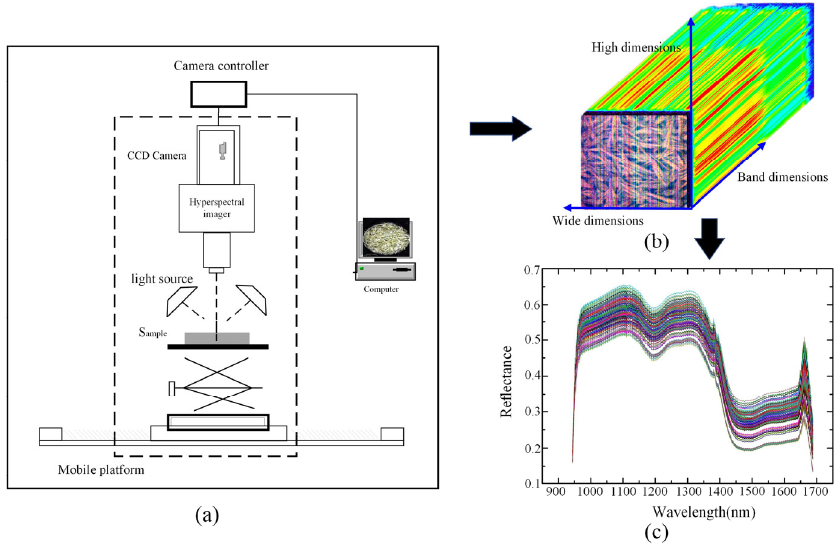
Figure 4. Hyperspectral Image and Spectral Data Acquisition Process, ( a ) hyperspectral imaging system, ( b ) hyperspectral image acquisition, and ( c ) extracted spectral reflectance.